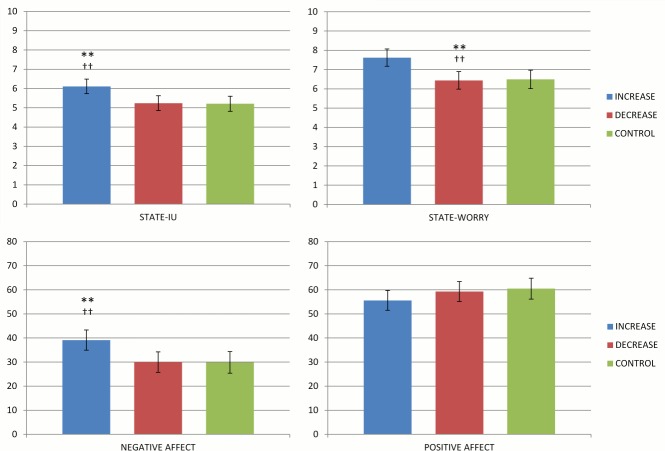
ANCOVA by condition.